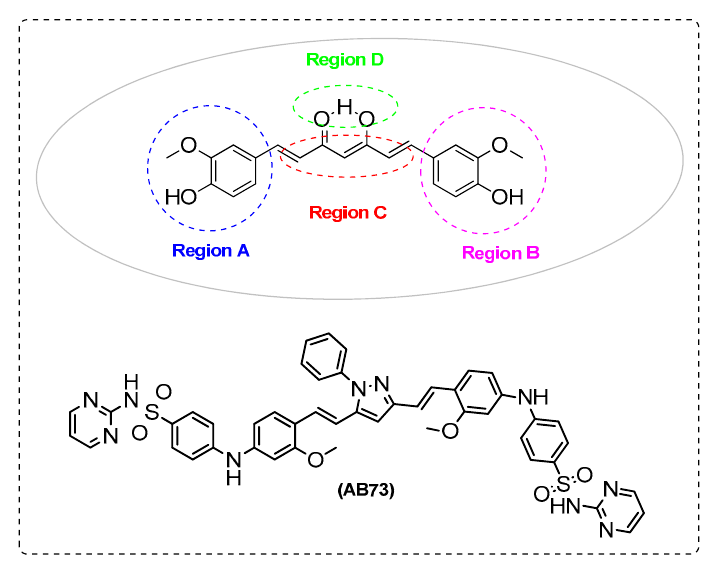
Figure 14. inhibitor. Figure 14. Antioxidant